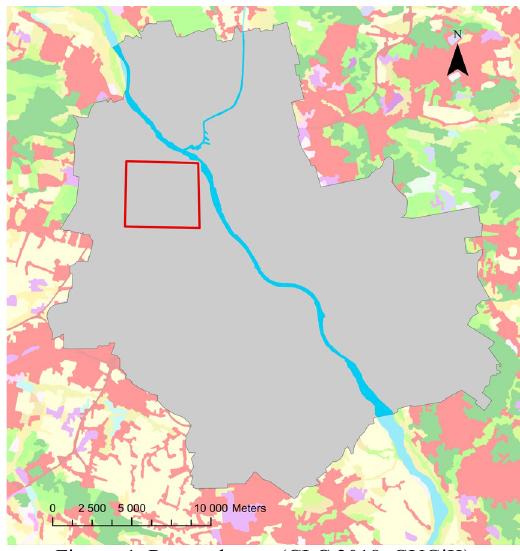
Figure. 1. Research area (CLC 2018, GUGiK)